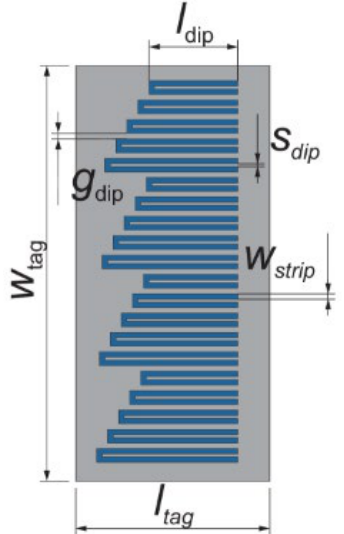
Figure 4. Sketch of 20-bit shorted re-arranged U-dipole tag. Table 1. Dimensions of shorted re-arranged U-dipole.